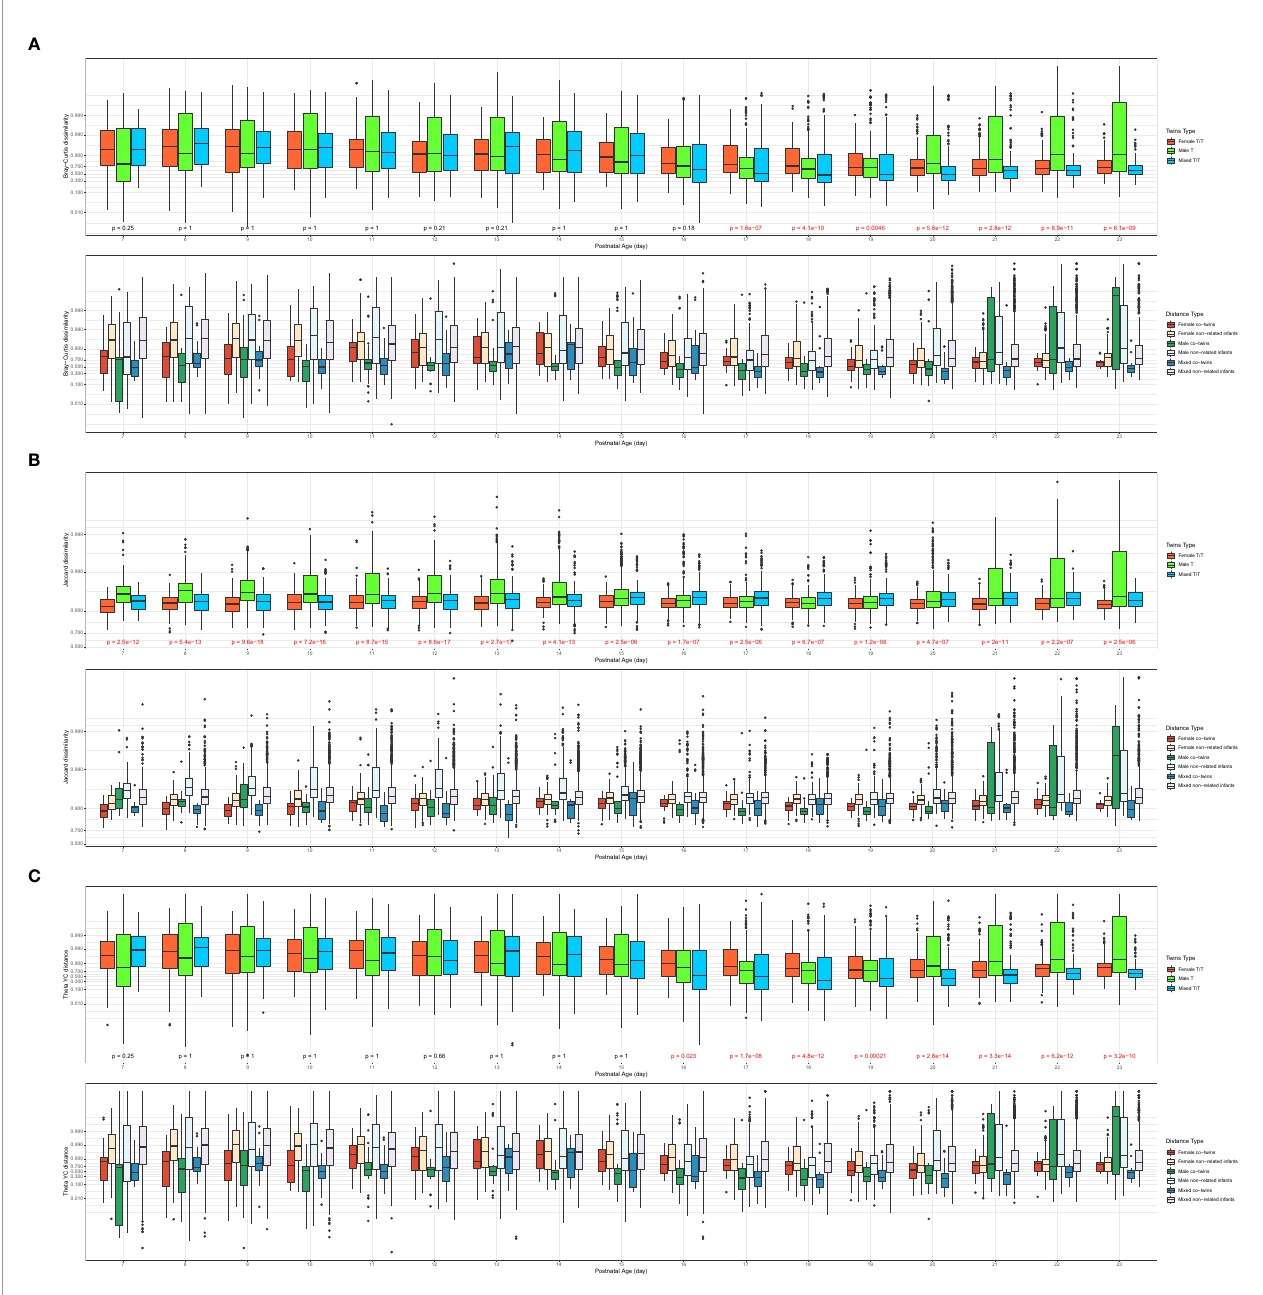
FIGURE 2 | Overall trend of b -diversities across twin types ( A : Bray-Curtis dissimilarity; B : Jaccard dissimilarity; C : Theta YC distance). In each of the sub fi gures, top panel: overall trend of b -diversities compared by the three twin types (Kruskal – Wallis test, signi fi cant p values colored in red); bottom panel: the trend of b -diversity across three twin types with co-twin pairs and non-related infants ’ pairs; x-axis: the averaged postnatal age for sample pairs; y-axis: the logit-transformed b -diversity measures between 0 and